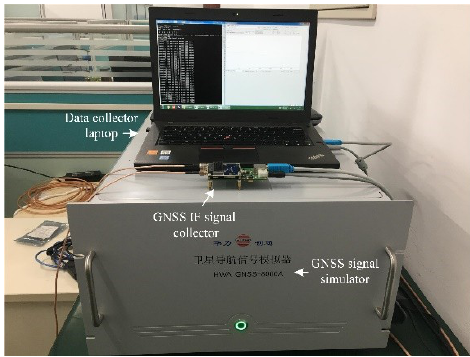
Figure 3. Data collection process with GNSS hardware simulator.